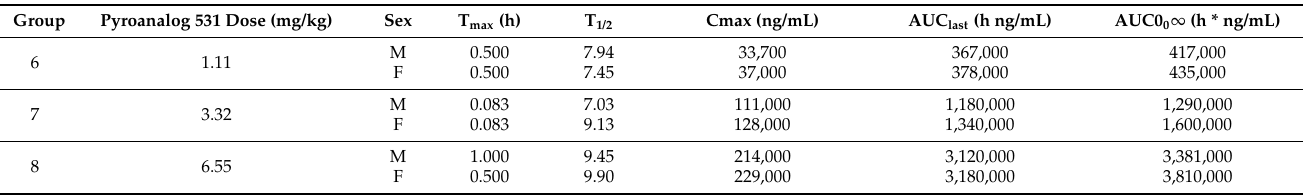
Table 2. Toxicokinetic parameters of PS 1 in